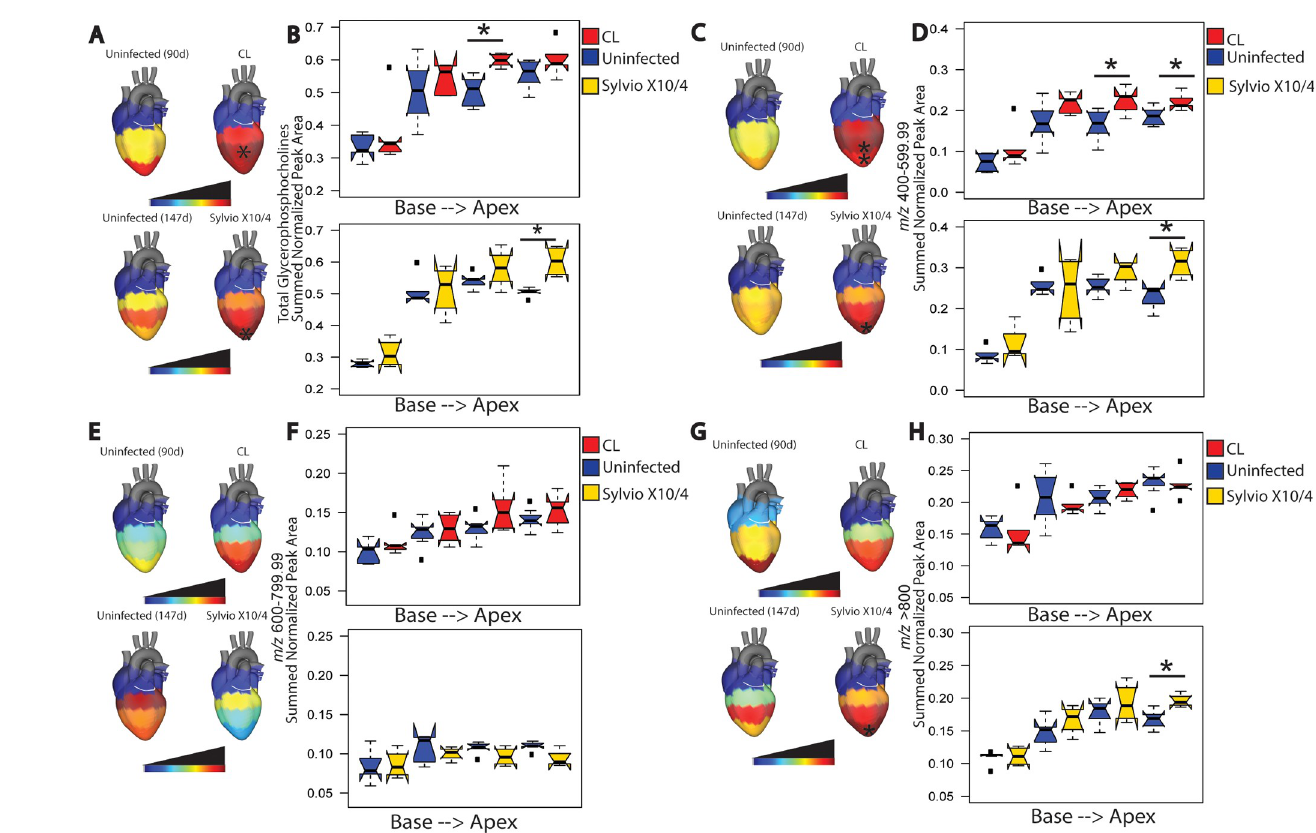
Fig 4. Spatial impact of chronic T . cruzi infection on cardiac glycerophosphocholines. (A, B) Differential total glycerophosphocholine distribution between uninfected and infected heart sections for both CL and Sylvio X10/4 strains. CL-infected mice showed statistically significant increases in total glycerophosphocholine levels at central heart positions when compared to uninfected mice ( � , p < 0.05 by Mann-Whitney test). (C,D) Both infected strains showed statistically significant increases ( � , p < 0.05, by Mann-Whitney test) for short glycerophosphocholines ( m/z 400–599.99) at central and apical positions for strain CL and apical positions for strain Sylvio X10/4. (E, F) Mid-sized glycerophosphocholines ( m/z 600–799.99) were not significantly affected by infection for both strains. (G, H) Sylvio X10/4-infected mice showed a statistically significant increase ( � , p < 0.05 by Mann-Whitney test) in long glycerophosphocholines ( m/z > 800) at apical